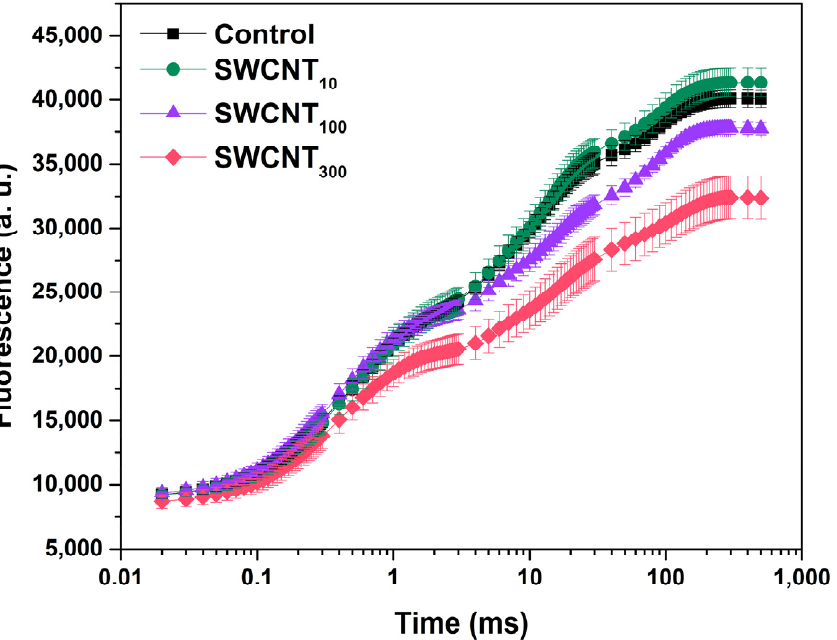
Figure 1. Prompt Chl fluorescence induction curves (±SEM) of intact pea leaves sprayed with distilled water (control), 10, 100 or 300 mg/L of polymer-grafted SWCNT.